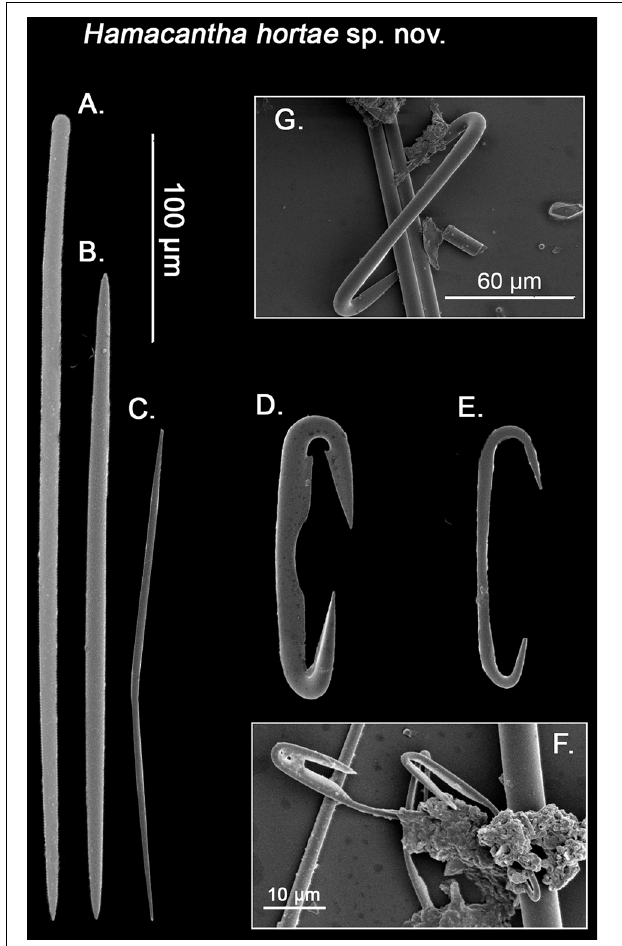
FIGURE 6 | SEM imagining of Hamacantha ( Hamacantha ) hortae sp. nov. spicular set. (A) Tylostyle; (B) Oxea I; (C) Oxea II; (D) Diancistra I; (E) developmental form of diancistra I, still lacking the hook-like expansions; (F) Diancistra II and (G) Lateral view of Diancistra I. Scale bar for (A–E) 100 µ m; scale bar for (F) 20 µ m; and scale bar for (G) 60 µ m.